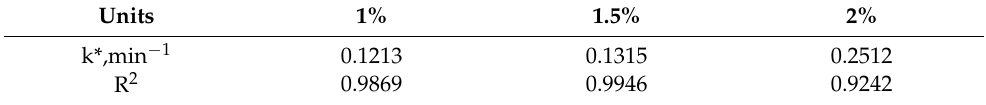
Table 6. Adjustment of data depending on catalyst concentration. Pseudo-first reaction